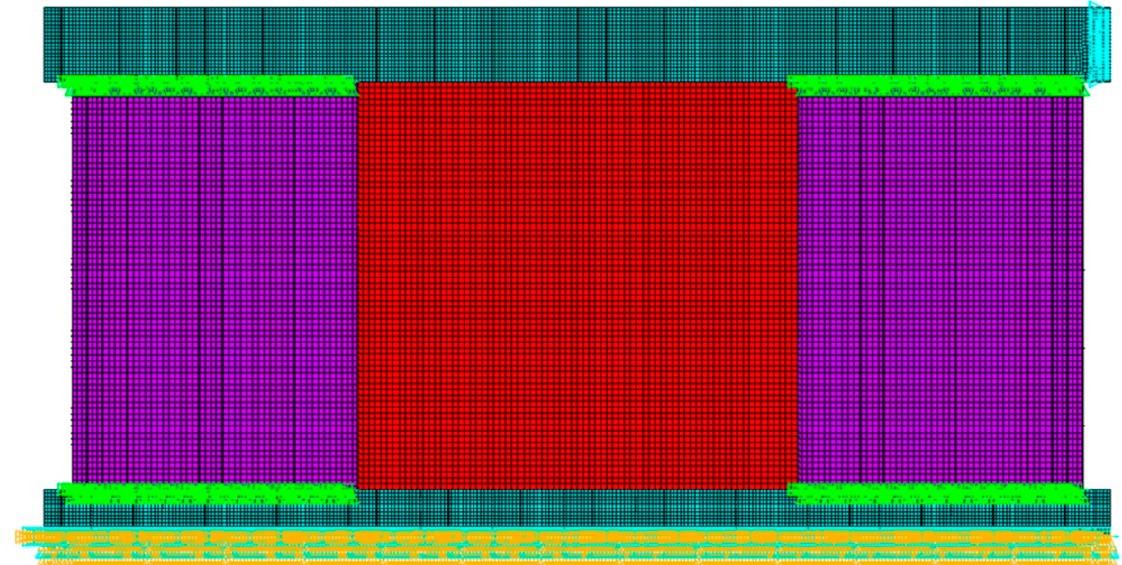
Figure 6. Finite element model of specimen W2.